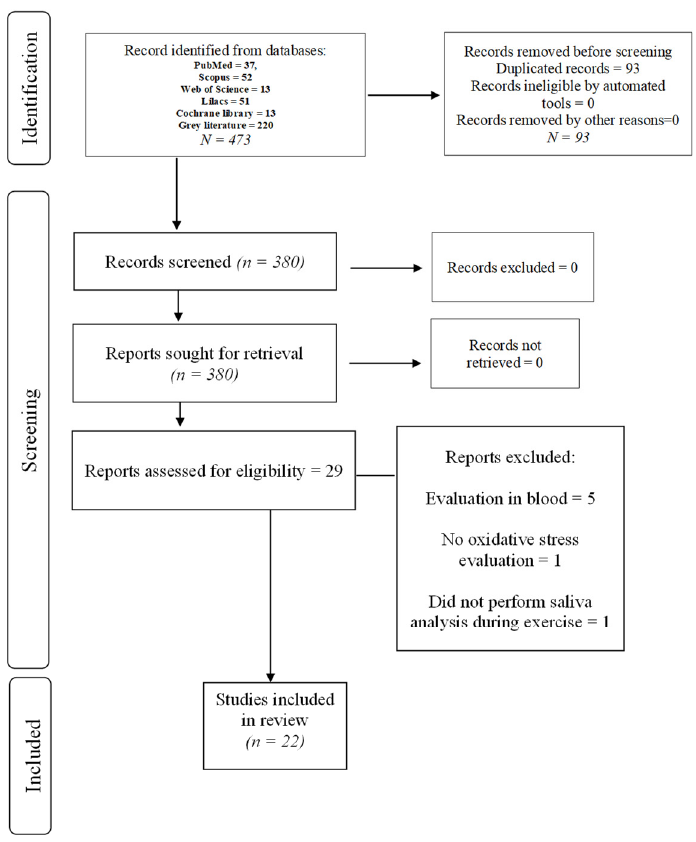
Figure 1. Prisma 2020 flow diagram of study selection